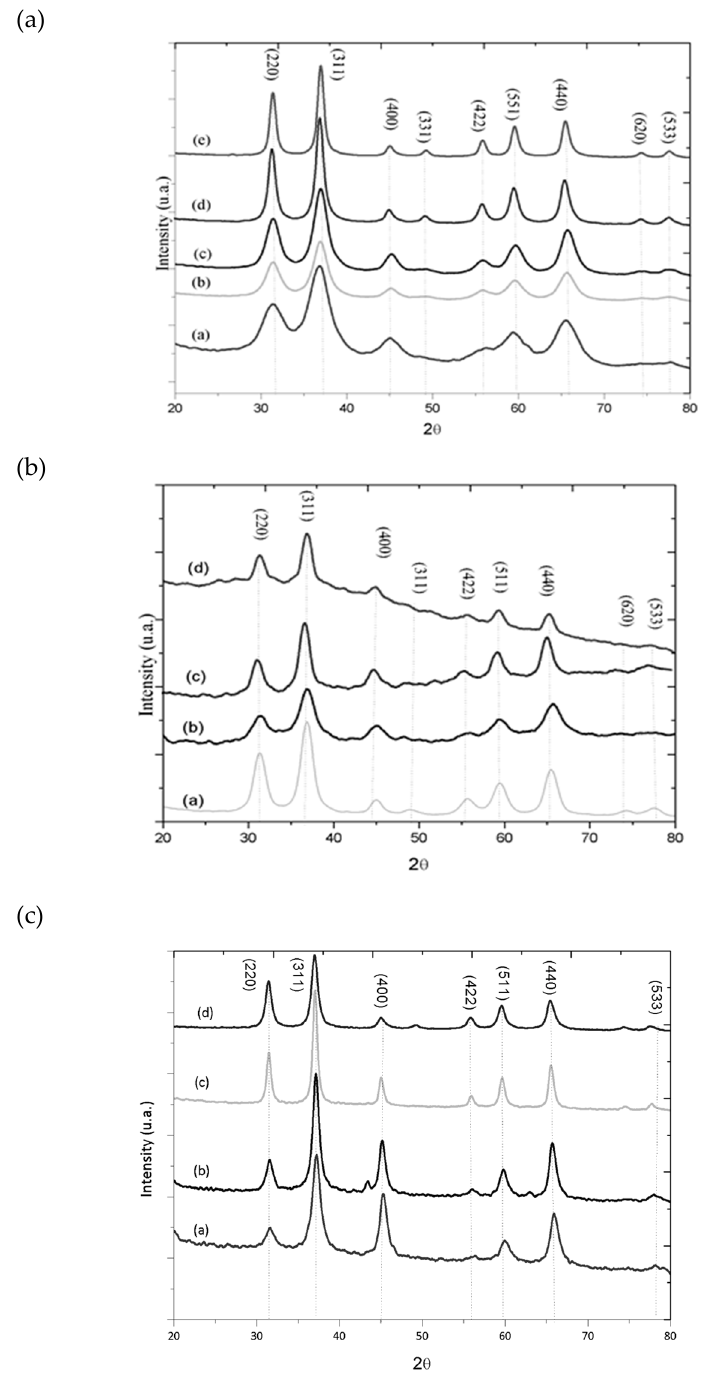
Figure 1. X-ray di ff ractograms of the samples obtained using the metal-chitosan complexation Figure 1. X-ray diffractograms of the samples obtained using the metal-chitosan complexation method: ( a )—(a) ZnAl 2 O 4 –550, (b) ZnAl 2 O 4 –650, (c) ZnAl 2 O 4 –750, (d) ZnAl 2 O 4 –850, (e) ZnAl 2 O 4 method: ( a )—a) ZnAl 2 O 4 –550, b) ZnAl 2 O 4 –650, c) ZnAl 2 O 4 –750, d) ZnAl 2 O 4 –850, e) ZnAl 2 O 4 –950; ( b )—